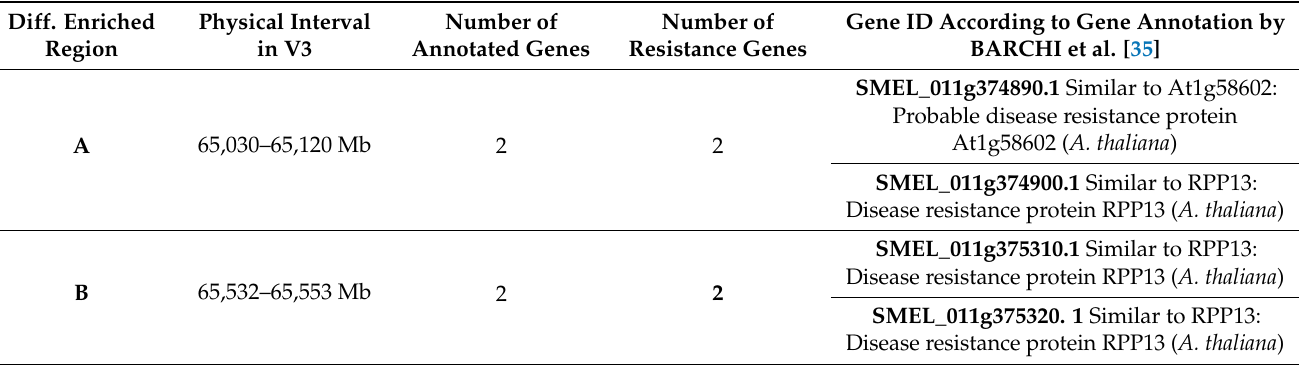
Table 4. List of differentially enriched regions within the confidence interval of QTL FomCH11 . For each region, extension, number of annotated genes, number of genes annotated as resistance genes and details for each best candidate gene according to the annotation in eggplant genome V3 [35] are reported.